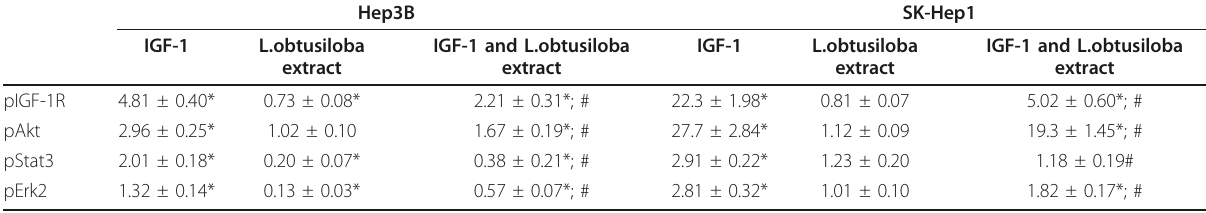
Table 3 Effects of L.obtusiloba extract on basal and IGF-1-induced signal transduction via IGF-1R